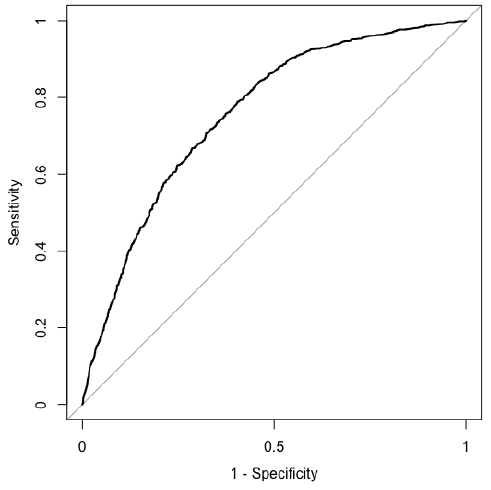
Figure 8. ROC curve for DNN (ReLU). (AUC = 0.751, F-score = 0.734).